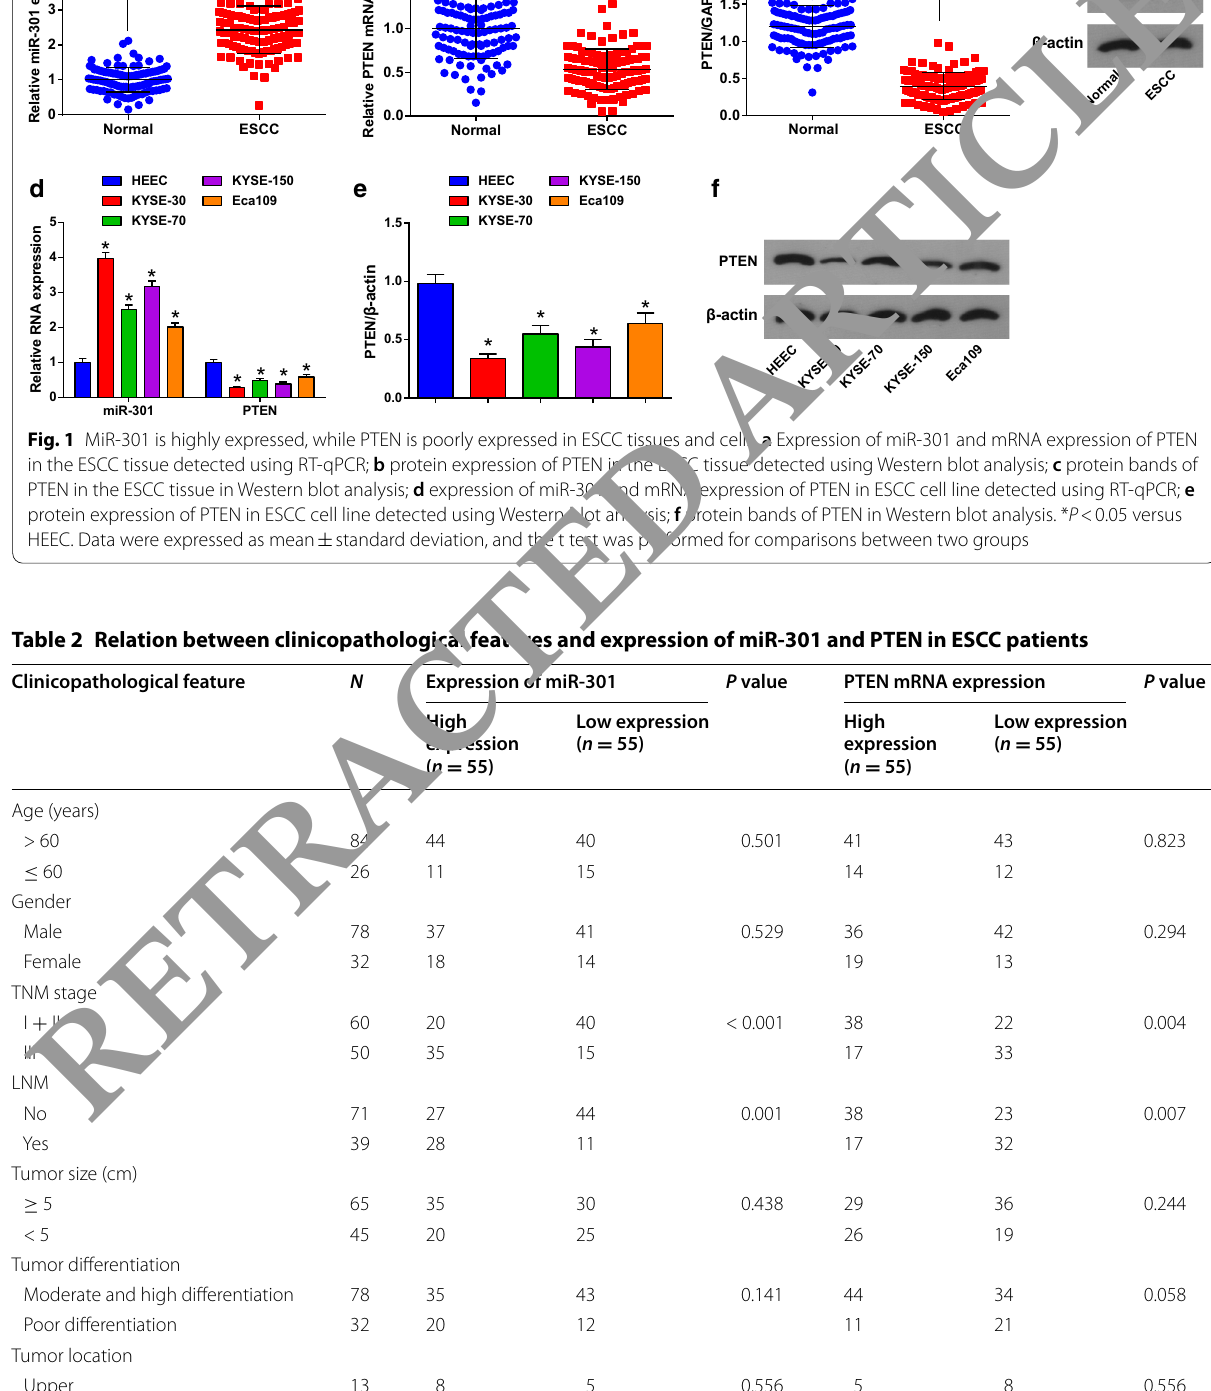
TNM, tumor–node–metastasis; LNM, lymph node metastasis